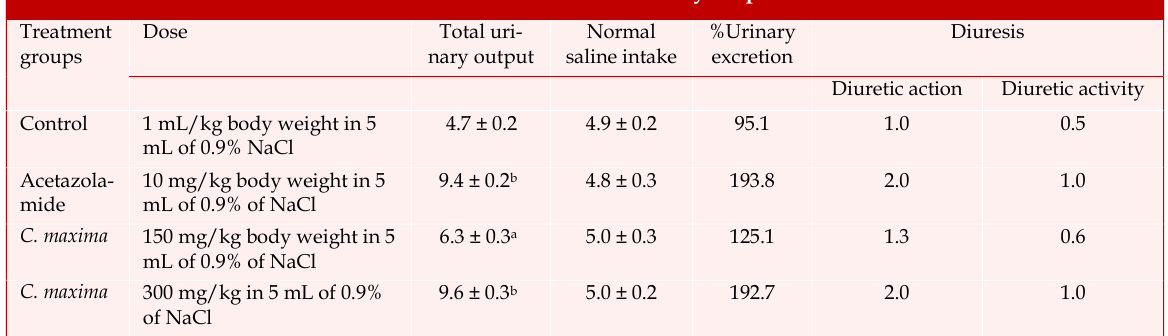
Effect of C. maxima extract on urinary output in rats